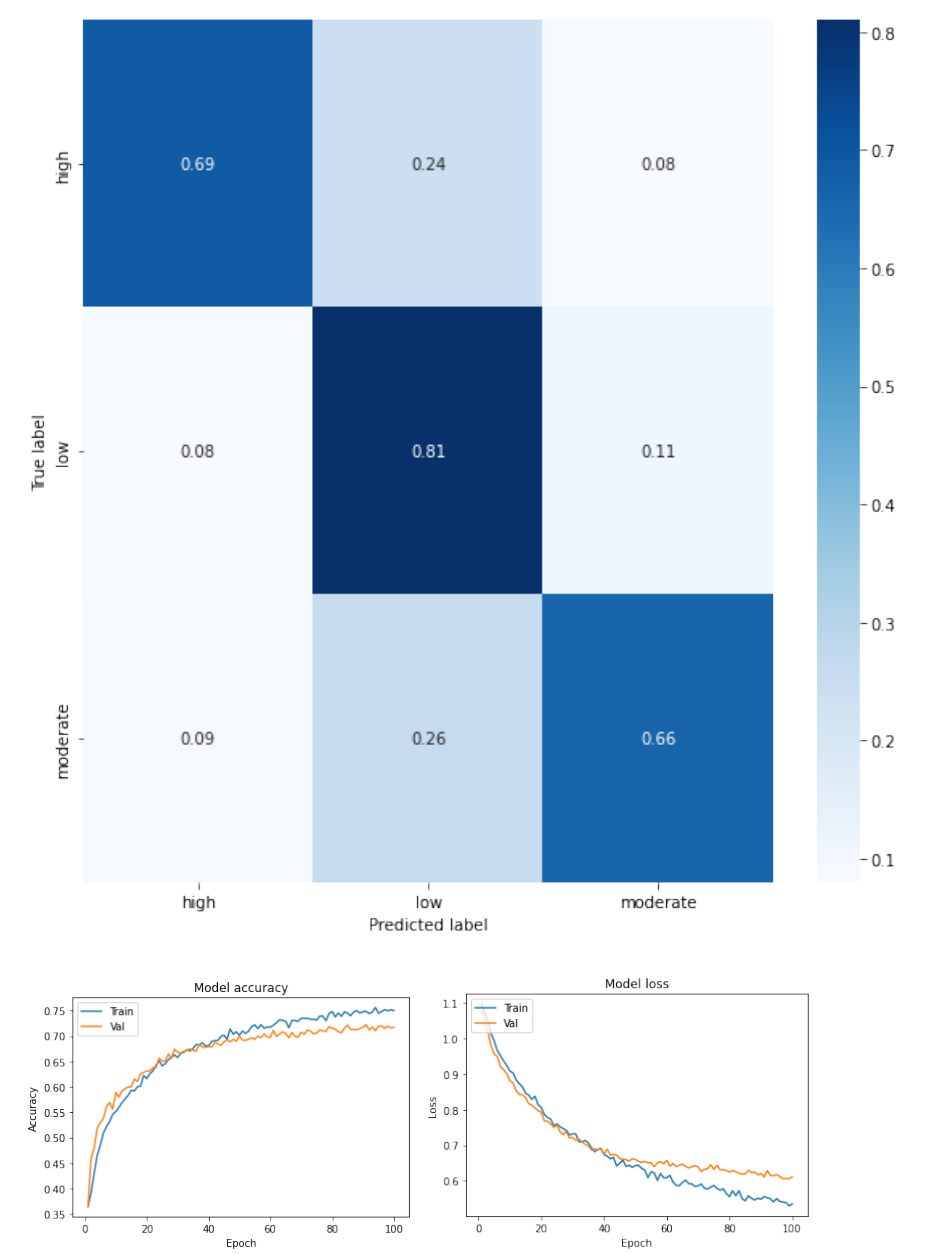
Figure 4. Confusion matrix, accuracy, and loss function for mild osteoarthritis and the three levels of FOF. Table 6. Performance metrics for three classes of FOF and mild KOA. Precision